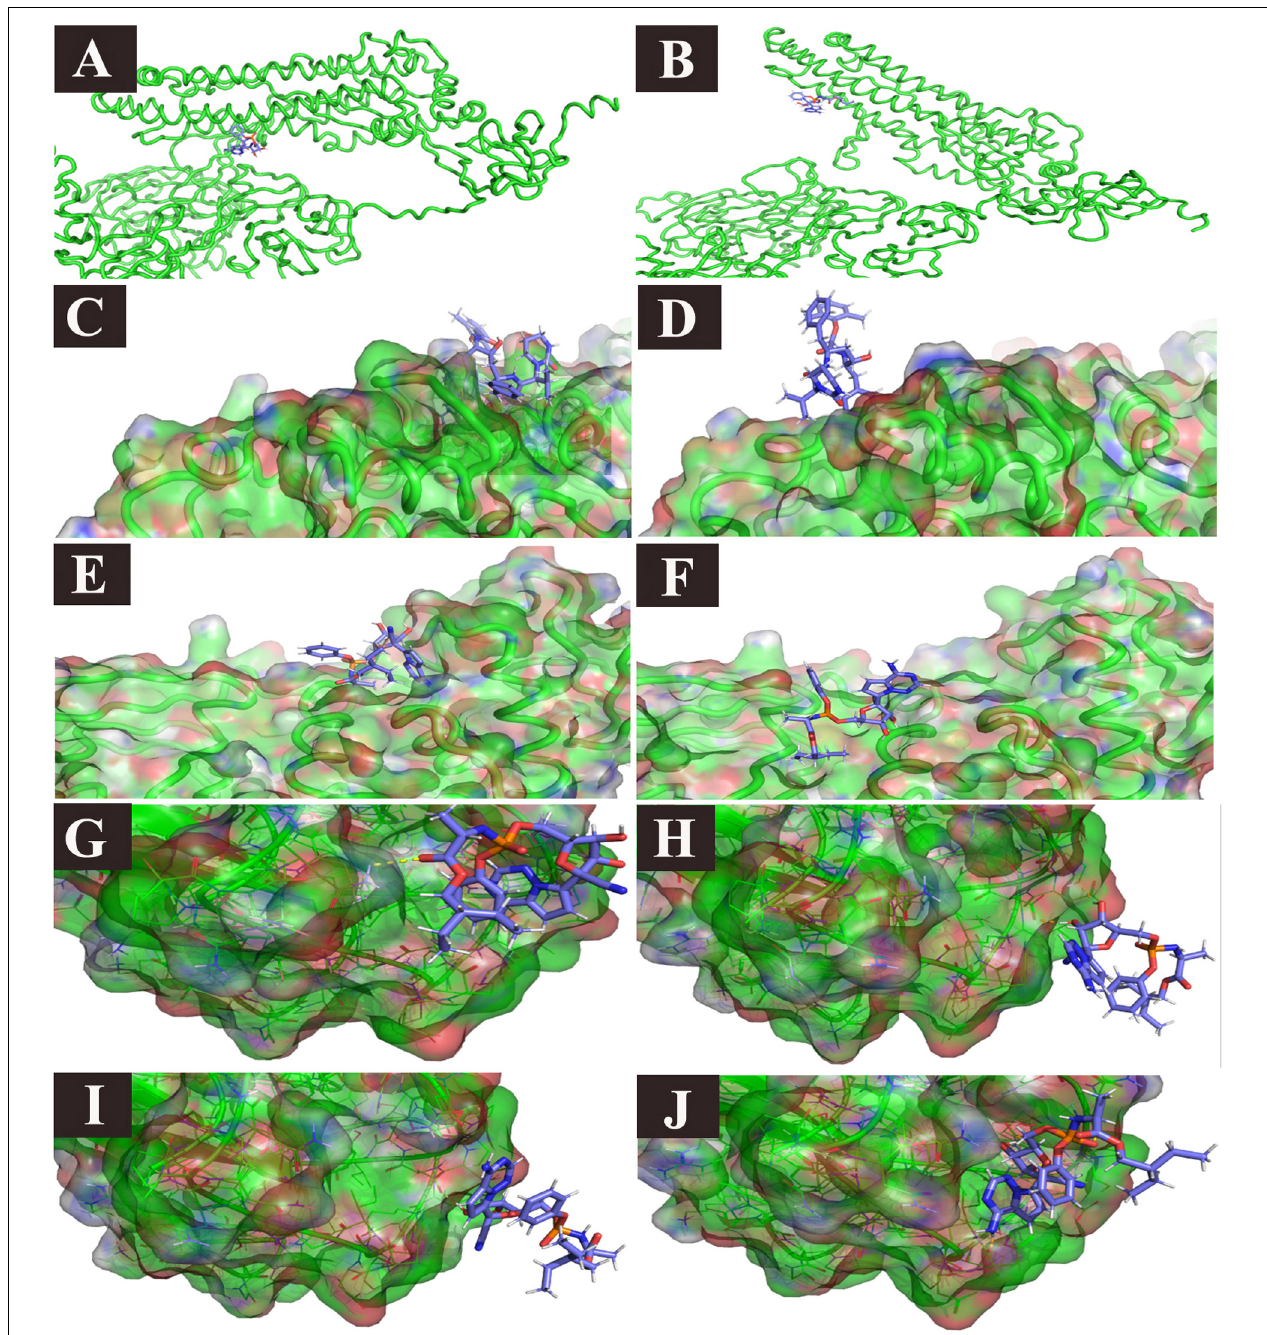
FIGURE 8 | Ligand/protein complex MD simulation: selected examples. (A) Remdesivir/spike ( t = 0): spike closes, (B) Remdesivir/spike ( t = 13 ns), the spike opens, and the ligand is still in place, (C) Lopinavir/PLpro ( t = 0), the ligand is in place, (D) Lopinavir/PLpro ( t = 26 ns), the ligand left the pocket. (E) Remdesivir/PLpro ( t = 0), the ligand is in place, (F) Remdesivir/PLpro ( t = 23 ns), the ligand moved to the other side of the pocket, (G) Remdesivir/NP ( t = 2 ns), the ligand is in the pocket, (H) Remdesivir/NP ( t = 21 ns), the pocket is obliterated, and the ligand left the pocket, but it is still attached to the receptor with two hydrogen bonds, and one Pi stacking, (I) Remdesivir/NP ( t = 22 ns), the pocket is still obliterated, and the ligand left the pocket, but it is still attached to the receptor with one hydrogen bond. (J) Remdesivir/NP ( t = 30), The pocket is open again and the ligand is restored in place.